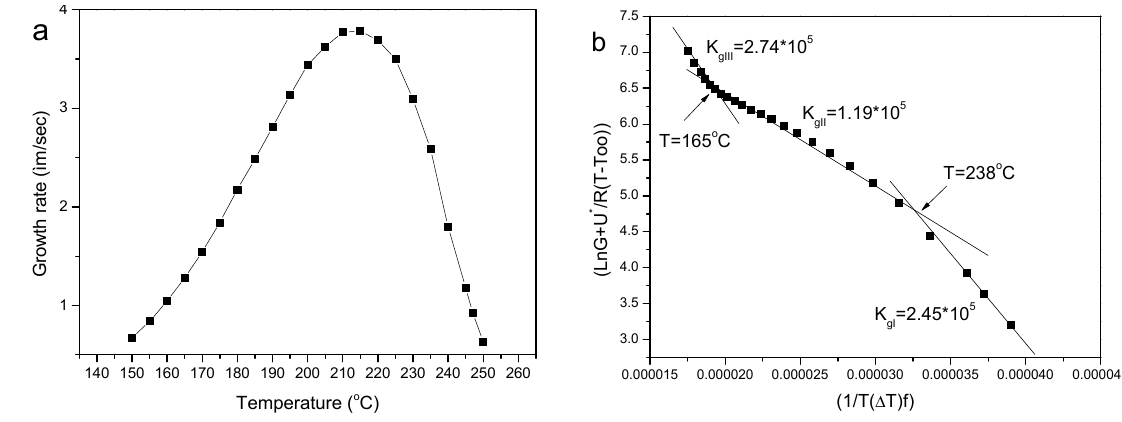
Figure 11. ( a ) Spherulite growth rates vs temperature and ( b ) Lauritzen-Hoffman plot for PEV.